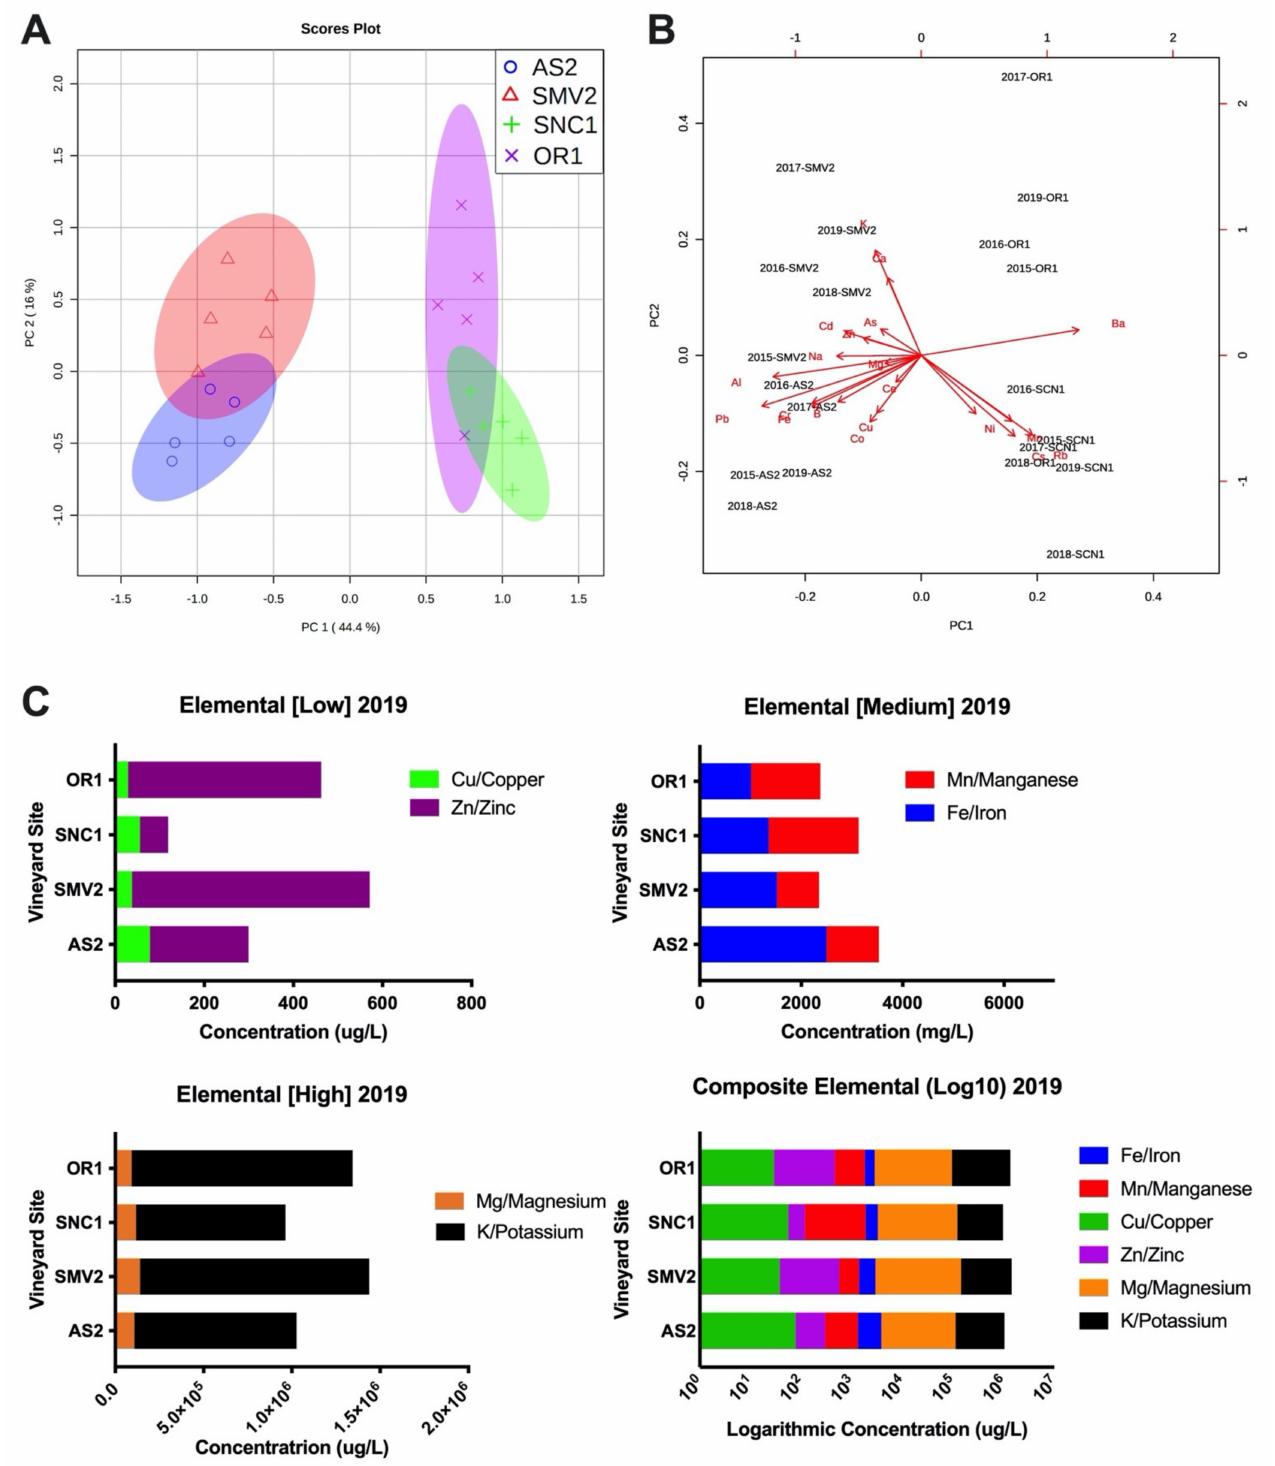
Figure 6. ( A ) Principal Component Analysis plot of elemental concentration and composition of the four vineyard sites; this analysis shows a clear segregation of the two “faster” and “slower” fermenting vineyard sites. PC1 captures 44.4% of the variation in the data set, while PC2 captures 16% of the variation in the data set. The ellipses represent a 95% confidence region. ( B ) As part of the same PCA analysis, the biplot shows the relative impact of which elements are driving the segregation of vineyard sites and vintages along PC1 (44.4%) and PC2 (16%). ( C ) Scaled concentration of yeast and redox relevant elements from the 2019 vintage; note the ratio of Fe/Mn between the faster (AS2/SMV2) sites vs. slower sites (SCN1/OR1). Check Supplementary Materials, Figure S3, for more Fe/Mn